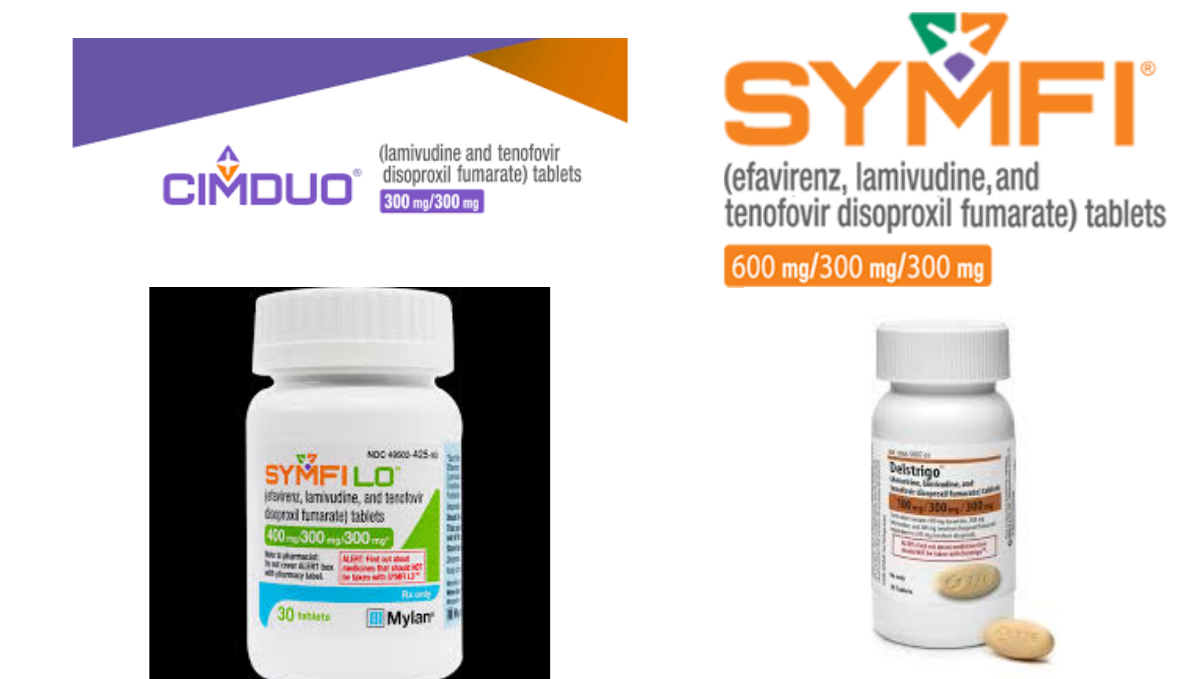
Figure 4. Overview of TDF- or TAF-containing combinations currently on the market.